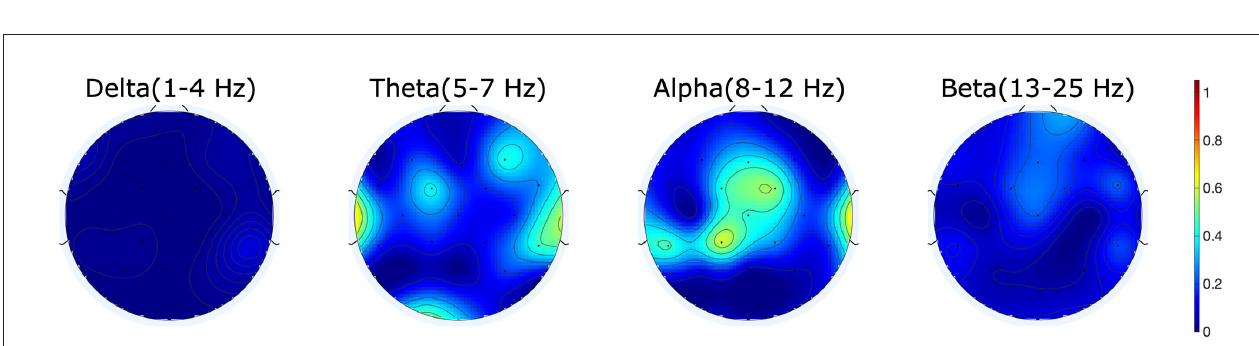
FIGURE 1 | The upper left plot shows the grand average ERPs for each trial class (error/correct) at electrode Cz ( n = 12). The experimental setup considered a human-robot interaction scenario in which the subject had to respond to a stimulus with a keypress (left, right, or up) indicating the target position, and a real robot turned its head either in the given direction or not, eliciting interaction ErrPs. On the right side, the different ERP displays the N2-P3 complex measured. The topographical distribution of the difference ERP shows that the N2 component is fronto-centrally located, and the characteristic P3 is also centrally located at around 300 ms. Results were reproduced from Ehrlich and Cheng (2016) using the publicly available datasets Ehrlich and Cheng (2019).